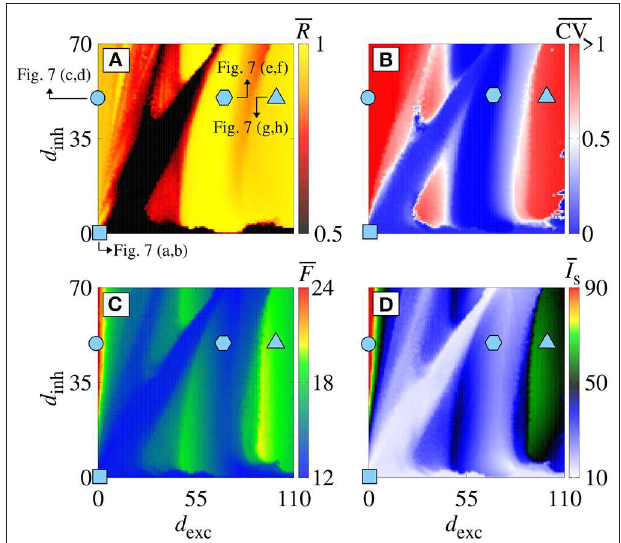
FIGURE 7 | Raster plots (top) and I syn ( t ) (bottom) for g exc = 0.8 nS, g = 6 for different values of d exc and d inh . Different delay values generate desynchronized spikes (A,B) , synchronized bursts (C,D) , synchronized spikes (E,F) , and synchronized bursts (G,H) .